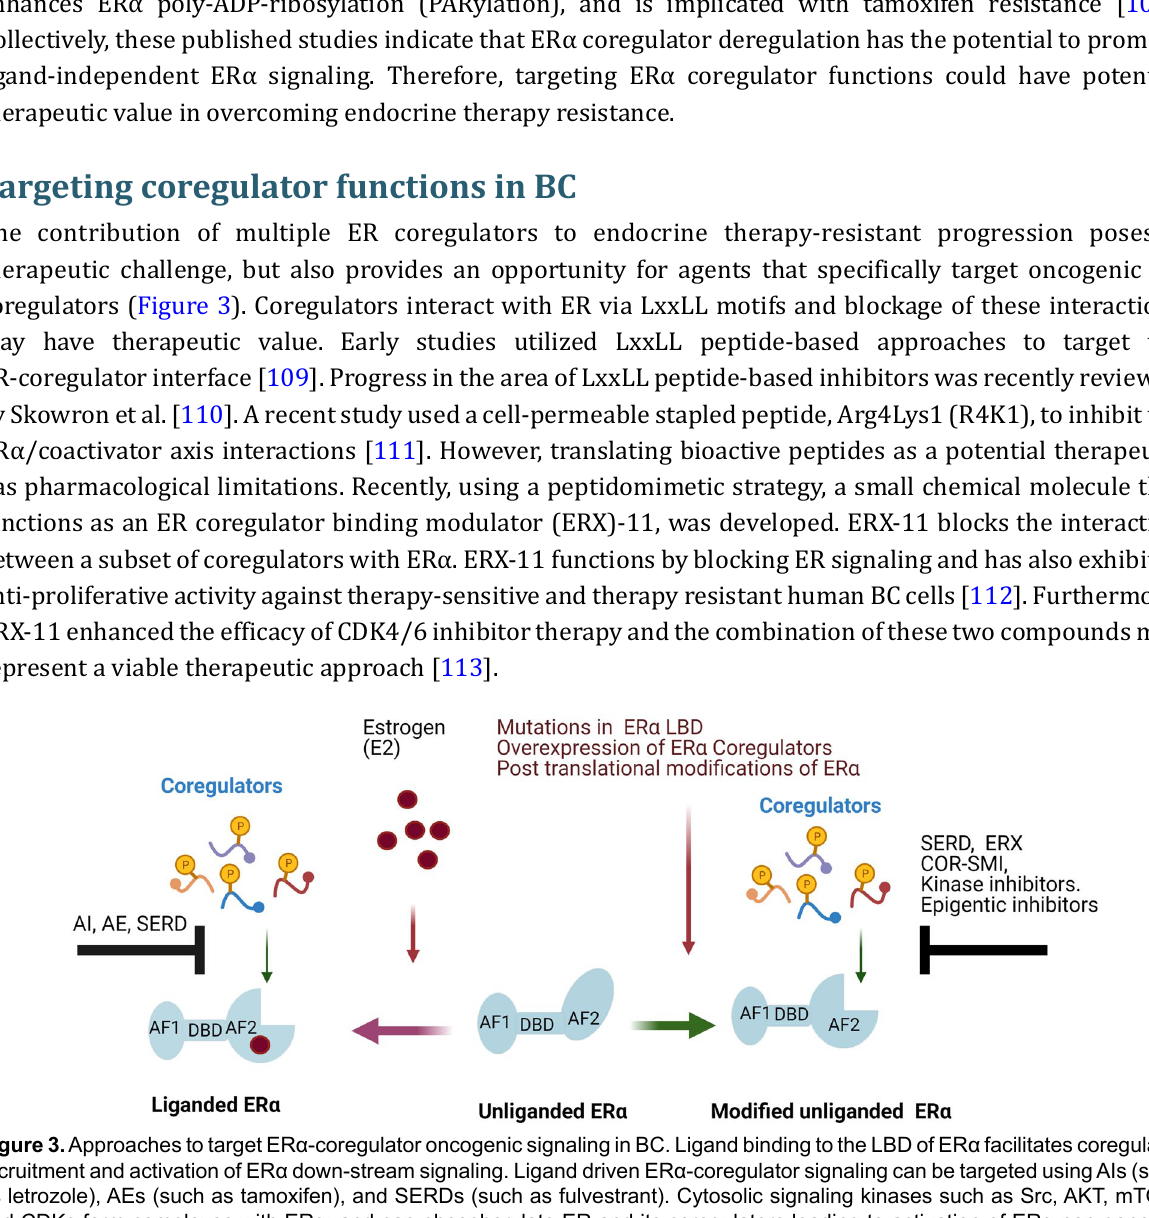
Explor Target Antitumor Ther. 2021;2:385-400 | https://doi.org/10.37349/etat.2021.00052